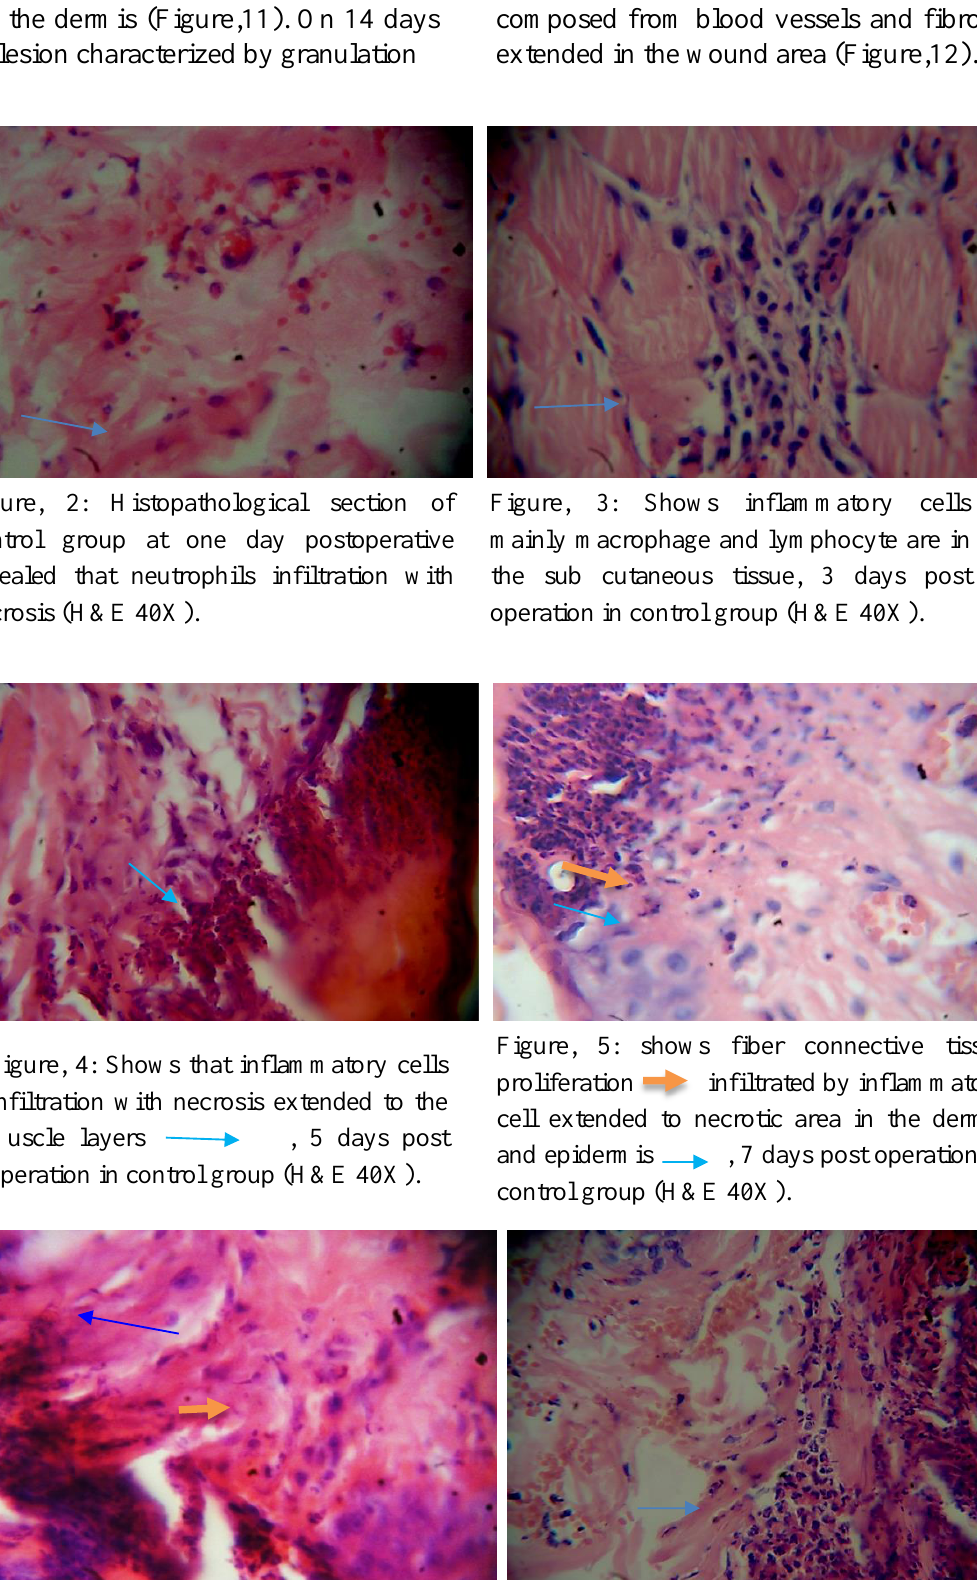
Figure, 7: Histopathological section in one day treated group, there is necrosis and neutrophil infiltration ,